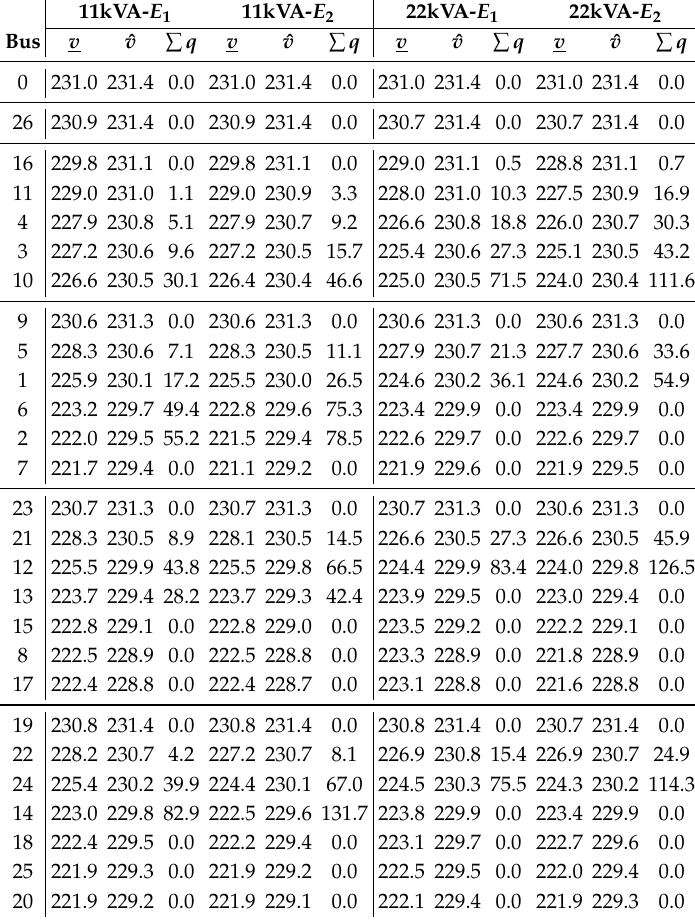
Table 6. Case study: voltage magnitudes per bus (V) and reactive power injections (kvarh). 11kVA- E 1 11kVA- E 2 22kVA- E 1 22kVA- E 2